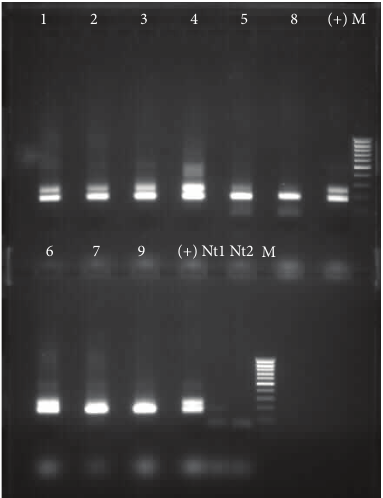
Figure 1: Electrophoretic separation of ssu-rRNA PCR products (175bp). Lanes 1–9, G. duodenalis positive samples through micros- copy; lanes (+), positive control ( G. duodenalis DNA, strain Port- land-1, ATCC 30888DTM LGC Promochem); lanes M, 100bp lad- der; lanes Nt1 and Nt2, negatives controls (no DNA) from the first and the second PCR reaction,